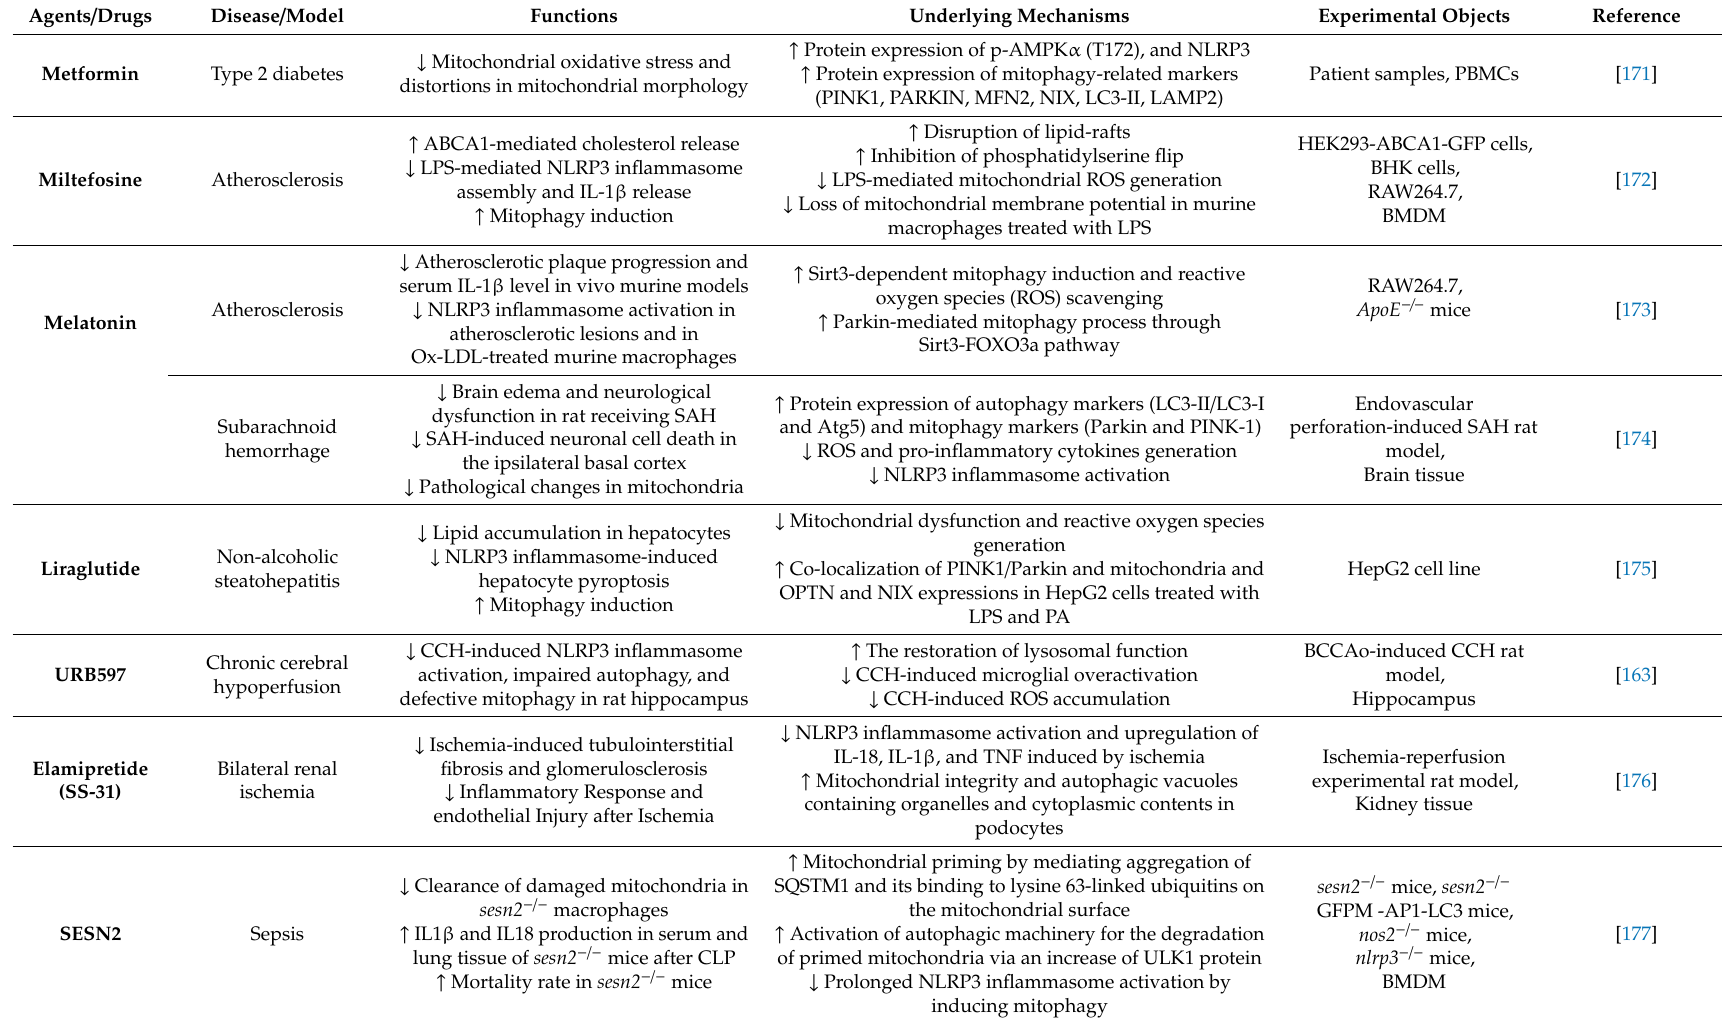
Table 1. Therapeutic candidates based on the regulation of mitophagy-inflammasome connection in human